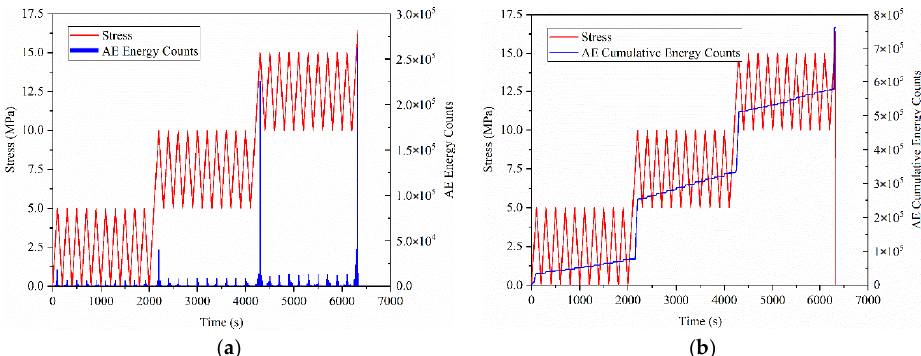
Figure 6. The AE energy characteristics of BC1 coal specimen; ( a ) Stress – Time – AE energy counting curve; ( b ) Stress – time – AE cumulative energy counting curve.